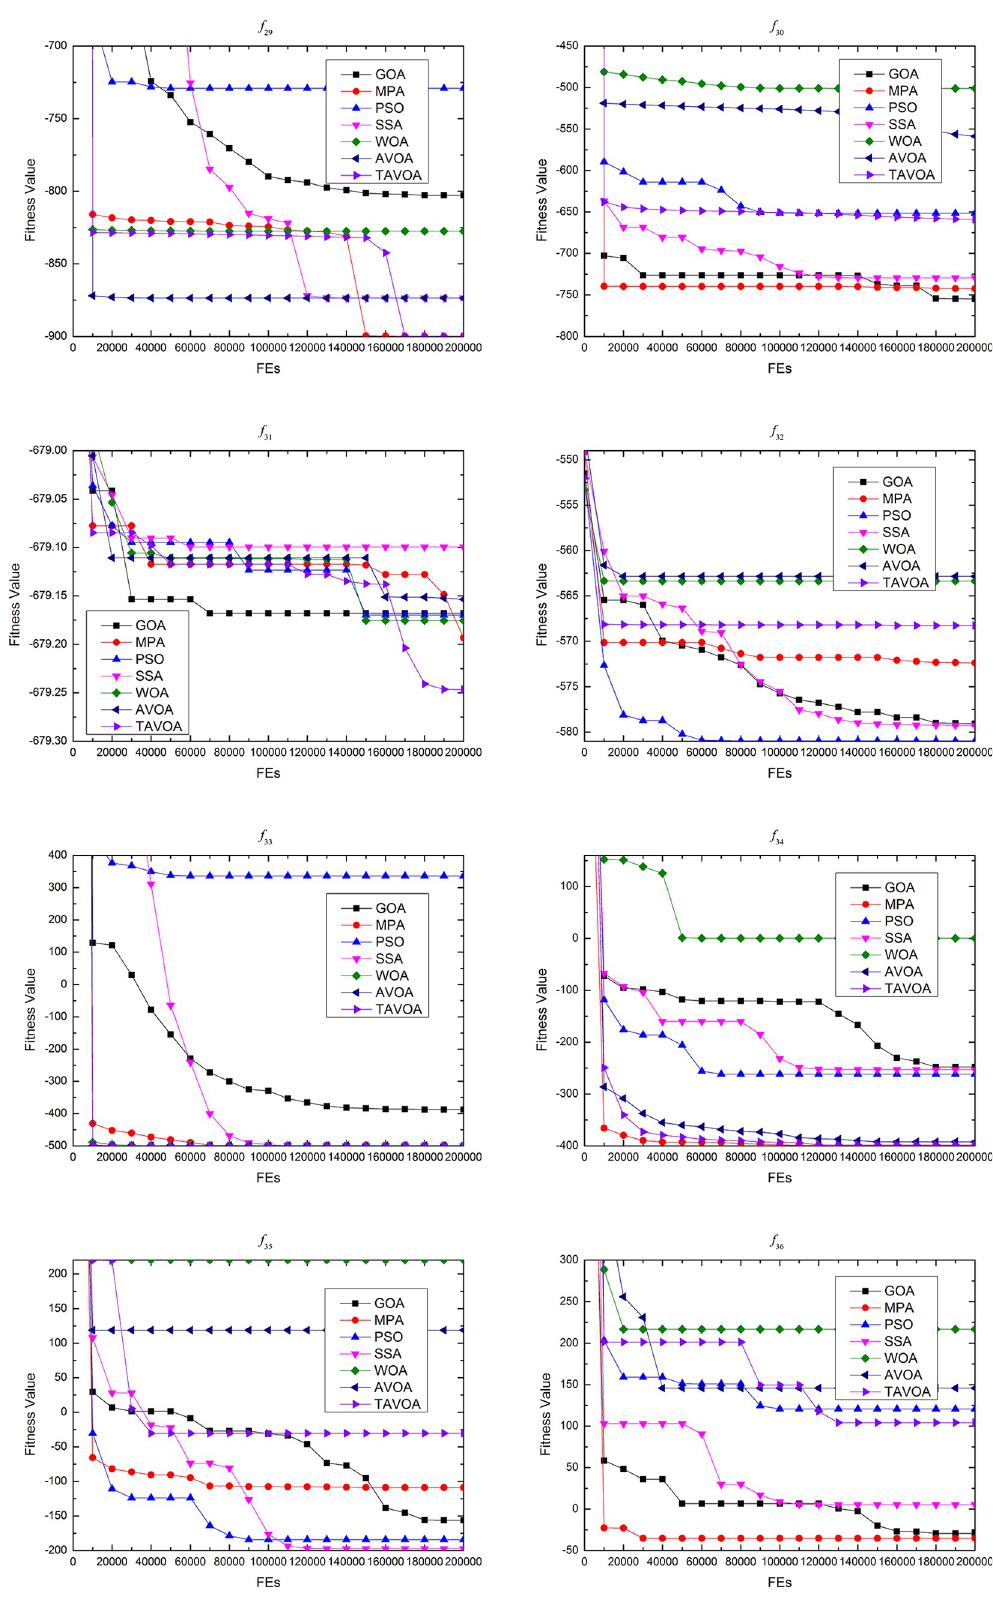
Fig 11. Convergence process on CEC 2013 multi-modal benchmark functions ( f 29 − f 36). https://doi.org/10.1371/journal.pone.0260725.g011 PLOS ONE | https://doi.org/10.1371/journal.pone.0260725 November30,